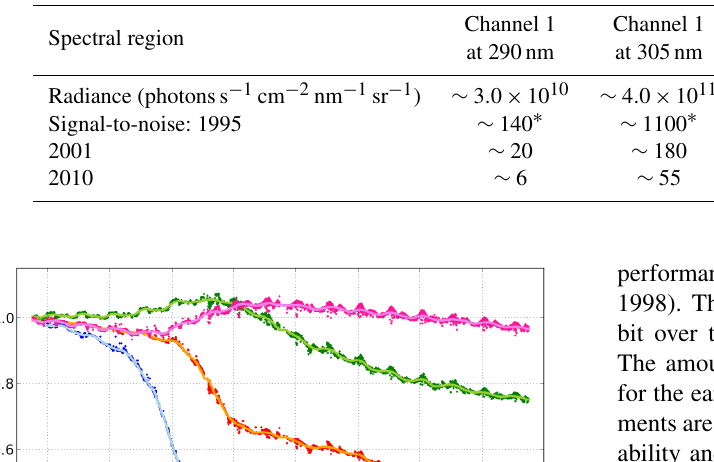
Table 1. Approximate signal-to-noise ratios at the beginning, middle, and end of the GOME mission for five spectral regions. ∗ Note that the values for channel 1 in 1995 are for an integration time of 6s whereas the other values are for an integration time of 1.5s.